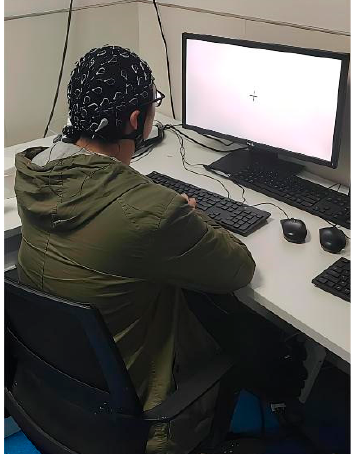
Figure 2. One of subjects is doing the experiment.